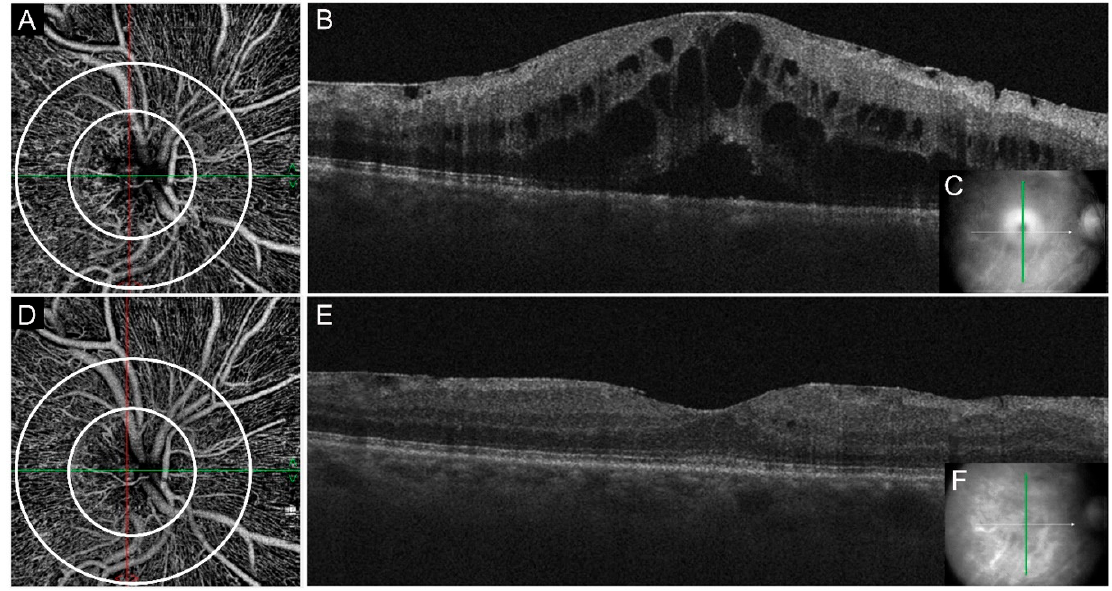
Figure 3. Optic nerve vessel density changes before ( A ) and after 4-months ( D ) from intravitreal anti-Vascular Endothelial Growth Factor (VEGF) injection. Inside disc and peripapillary VD are highlighted by white circles. Follow-up OCT vertical scans show a reduction of macular edema from baseline ( B , C ) to 4-months ( E , F ).